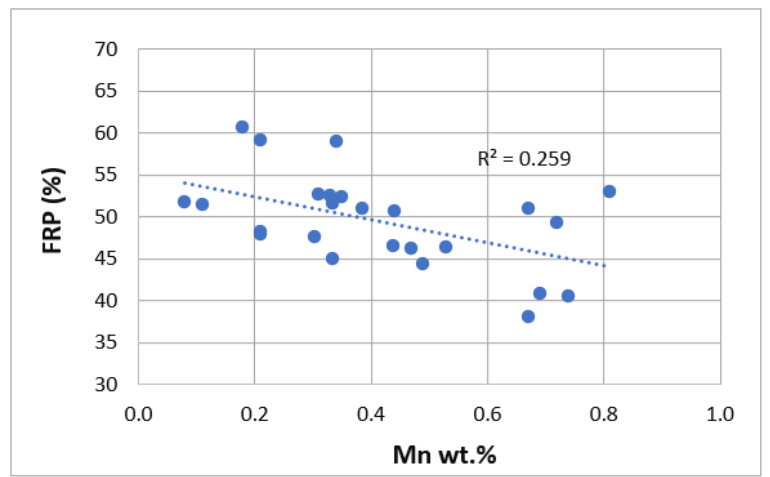
Figure 4. Comparison of FRP (%) as a function of Mn wt.%.